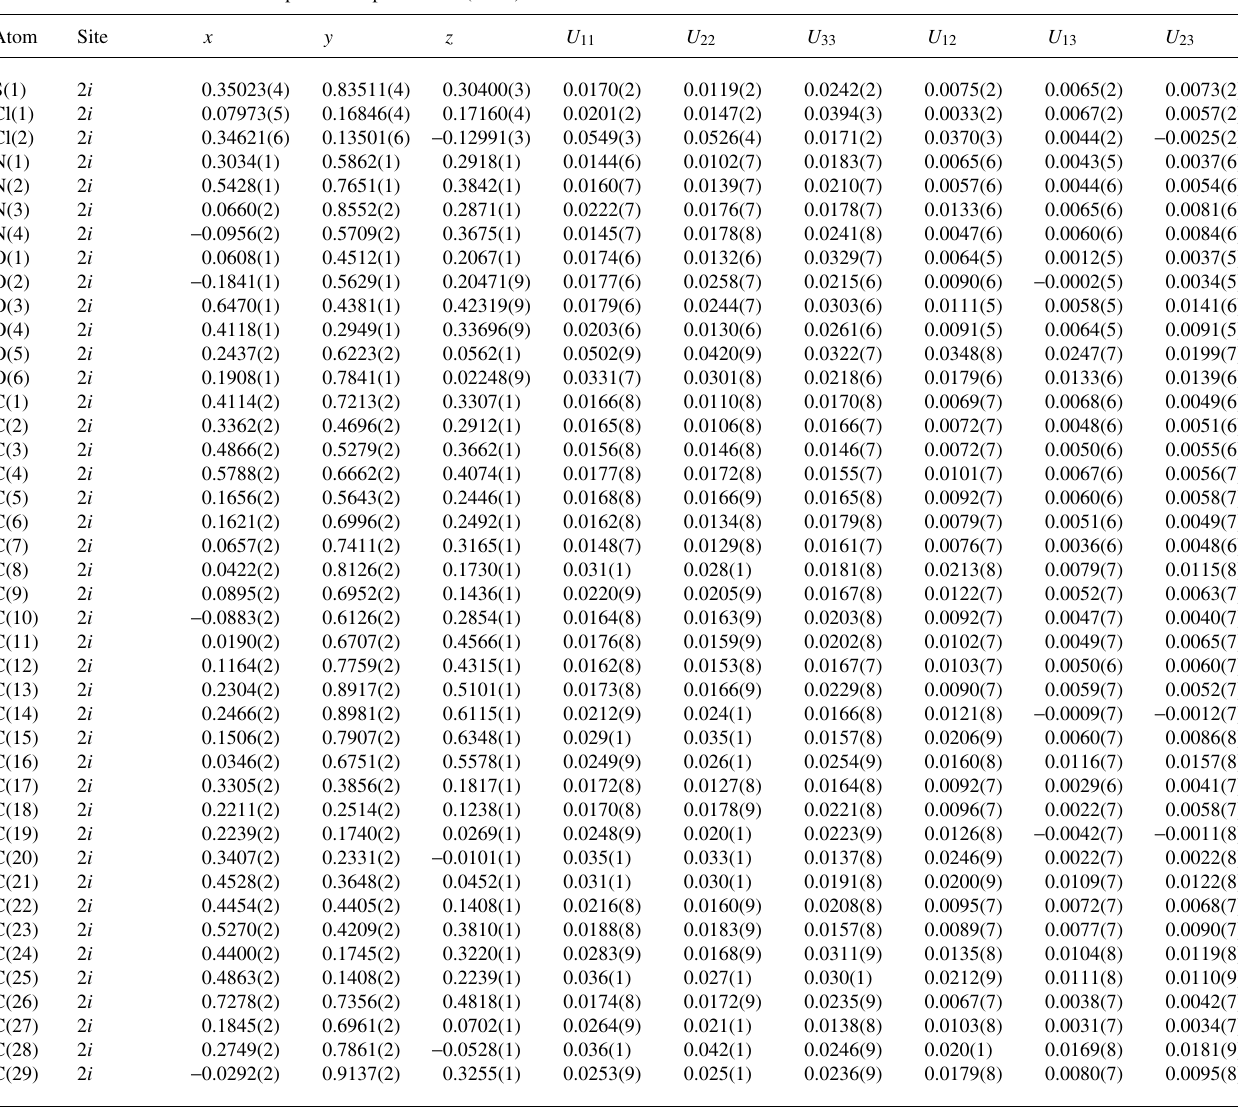
Table 3. Atomic coordinates and displacement parameters (in Å 2 )